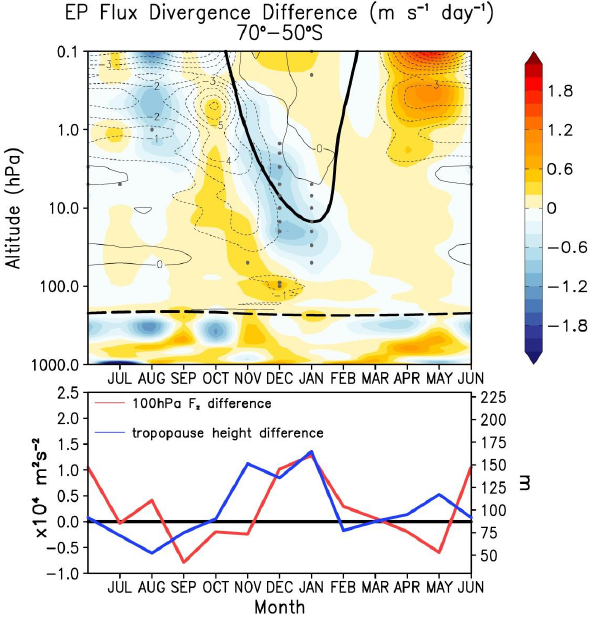
Figure 8. Zonal mean, monthly mean EP flux divergence REF2000 climatology (contours) and difference between REF2000 and NHC (shaded), averaged over 70–50 ◦ S. Contour intervals are 1ms − 1 day − 1 , solid/dashed contours represent positive/negative changes. Stippling denotes significance at the 95% confidence level. The zero wind line from REF2000 is highlighted in bold, while the bold dashed line signifies the tropopause height in the REF2000 simulation. The lower panel shows the zonal mean, monthly mean difference to the vertical component of the EP flux, F z ( × 10 4 m 2 s − 1 ) , in red (left-hand axis), and the zonal mean, monthly mean difference to tropopause height (m) in blue (right- hand axis), both averaged over 70–50 ◦ S.